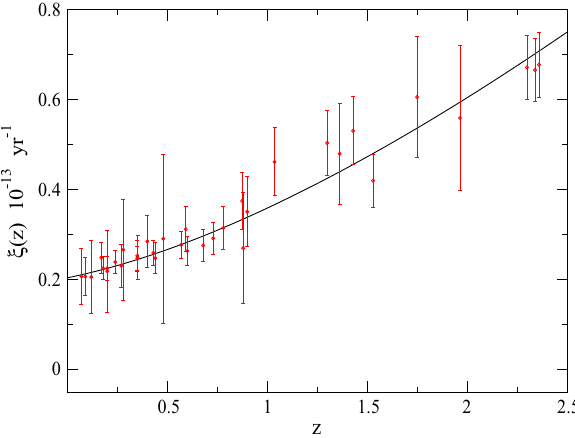
Fig. 3 The total mass drift rate ξ( z ) , given by Eq. (23) as predicted by the RVM, as a function of the redshift and within the same conditions as in the previous figure. Here ν X = 10 − 3 , which essentially saturates the fitted value of ν m (recall that ν B (cid:8) ν m ; see the